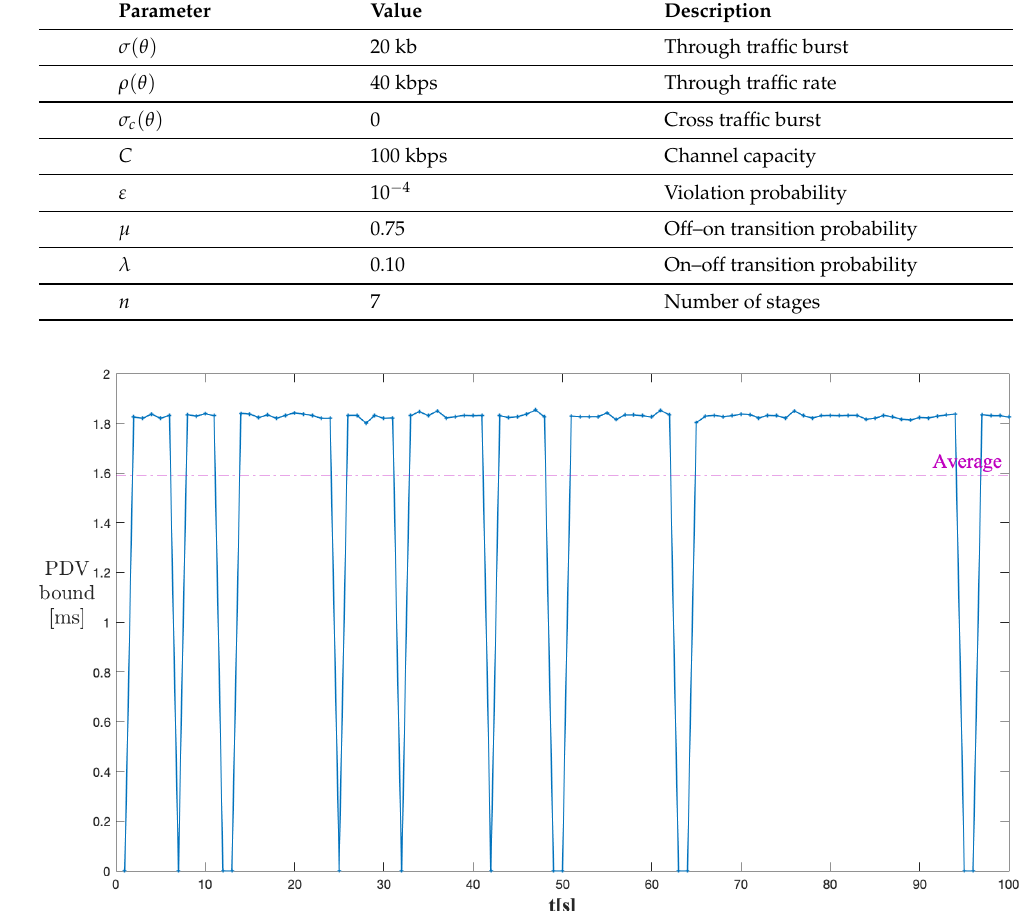
Figure 12. PDV bound output for through traffic (time